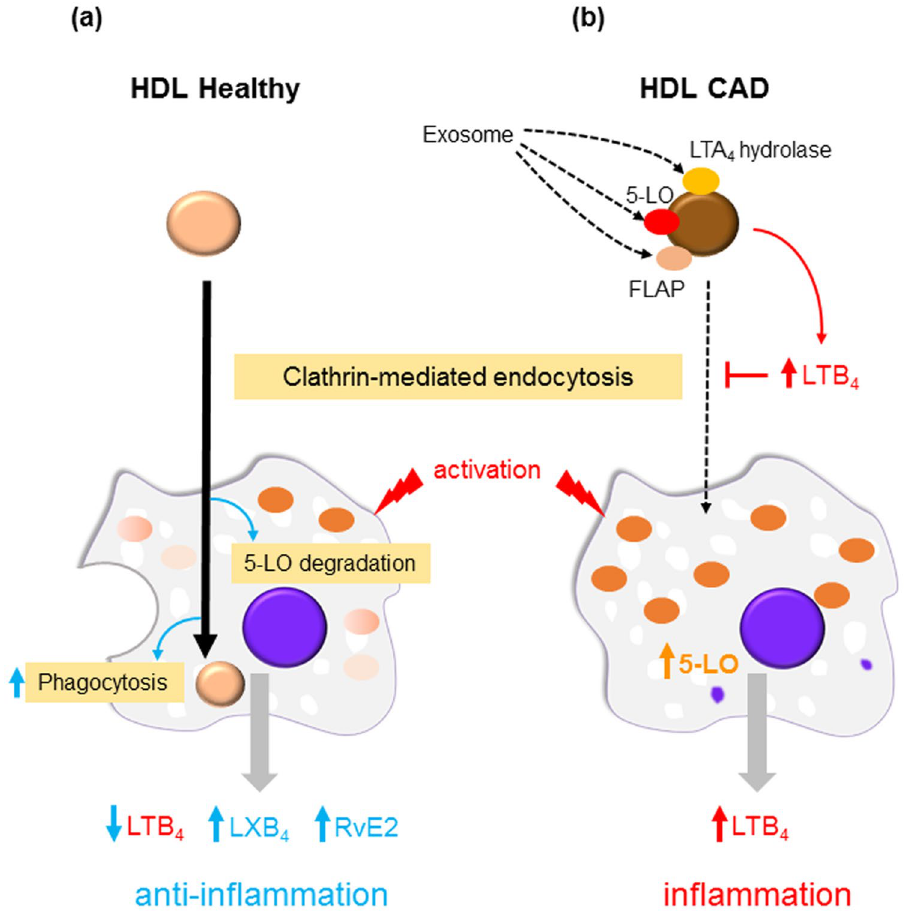
Figure 7. Proposed HDL functions: regulation of LTB 4 production from activated macrophages via HDL engulfment. ( a ) HDL Healthy is engulfed by macrophages via clathrin-mediated endocytosis and attenuates 5-LO expression by the ubiquitin proteasome system, thus resulting in decreased LTB 4 from activated macrophages. HDL Healthy enhances LXB 4 and RvE2 production, as well as phagocytosis in macrophages. ( b ) HDL CAD produces de novo LTB 4 , which interferes with HDL engulfment into macrophages. Here, 5-LO escapes from HDL- mediated degradation, thereby resulting in continuous LTB 4 production from activated